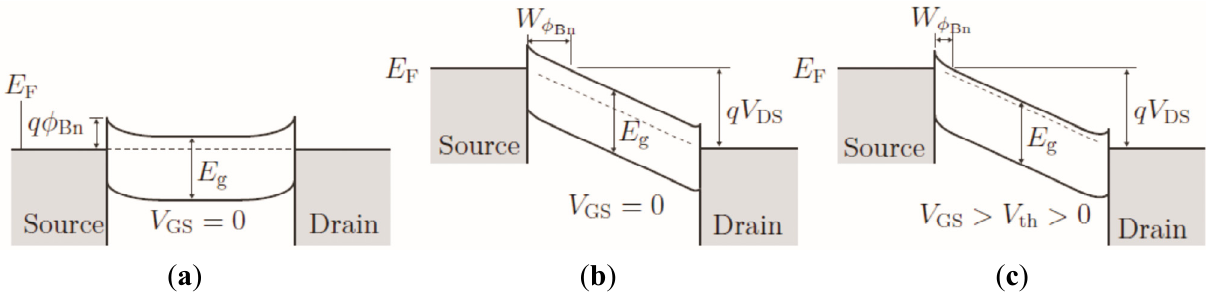
Figure 1. Band diagram of the Schottky contacts to an n-type semiconductor with metal contacts: ( a ) without applied voltages; ( b ) with drain voltage and ( c ) with drain and gate voltages. © 2015 IEEE. Reprinted, with permission, from [3].